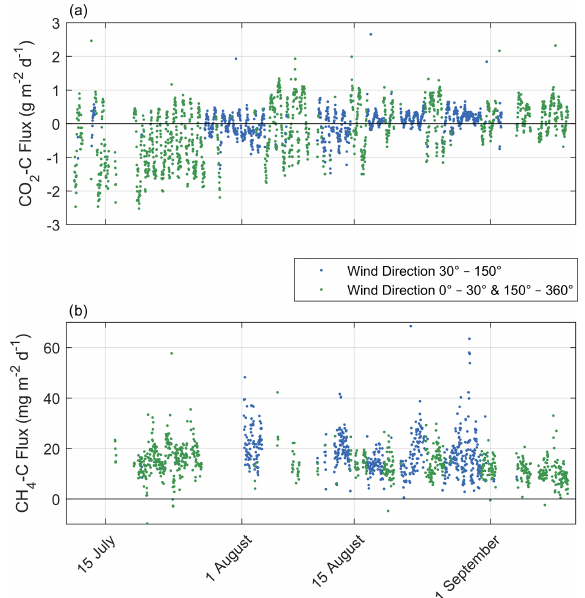
Figure A3. Time series of 30min observed CO 2 –C flux intervals (a) and CH 4 –C flux (b) with a quality flag of 0 or 1. The blue color represents fluxes originating from the wind direction of the merged polygonal pond (30–150 ◦ wind direction, mostly mixed signals from semi-terrestrial tundra and the surface of the merged polygonal pond), and the green color represents fluxes originating from all other wind